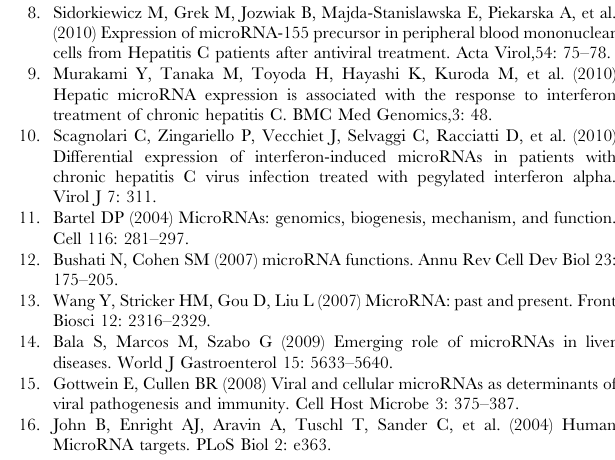
Figure S3 MiR-30(a–d)-associated gene targets in the Regulation of Actin Cytoskeleton pathway. (TIF) Figure S4 MiR-130a-associated gene targets in the TGF- b signaling pathway. (TIF) Figure S5 MiR-130a-associated gene targets in the Endocytosis pathway.